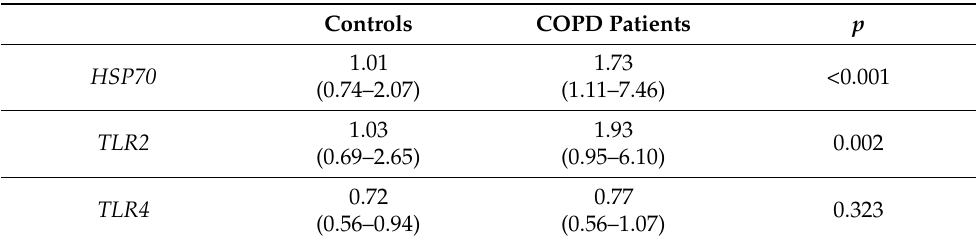
Table 3. Relative expression of HSP70 , TLR2 and TLR4 in controls and COPD